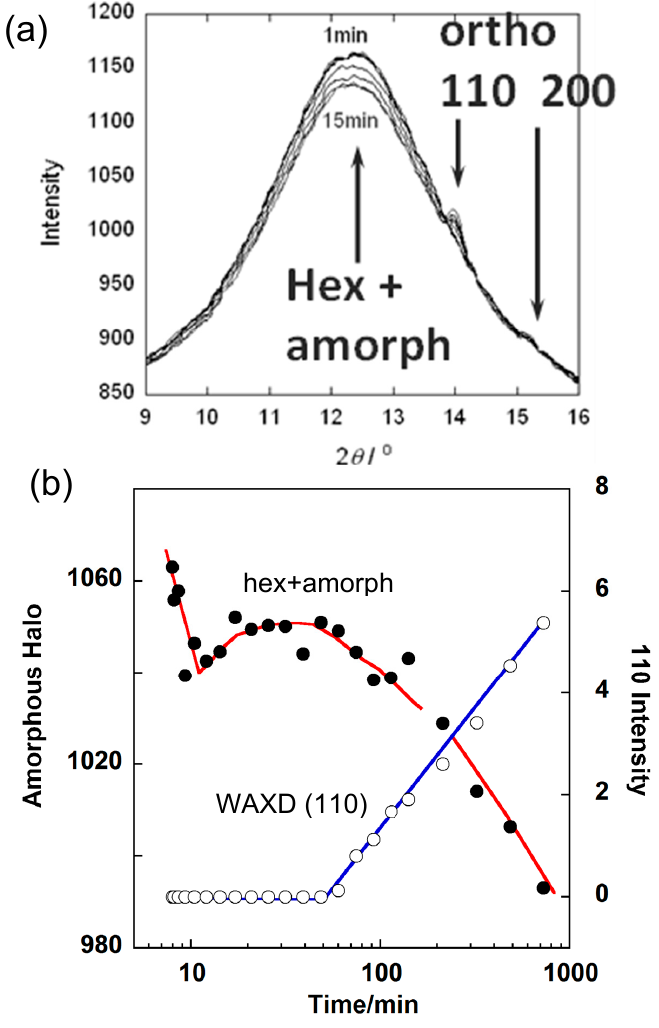
Figure 10. Time dependence of ( a ) WAXD profile and ( b ) the intensity of the amorphous halo and (110) reflection obtained in the isothermal crystallization of high-density polyethylene.